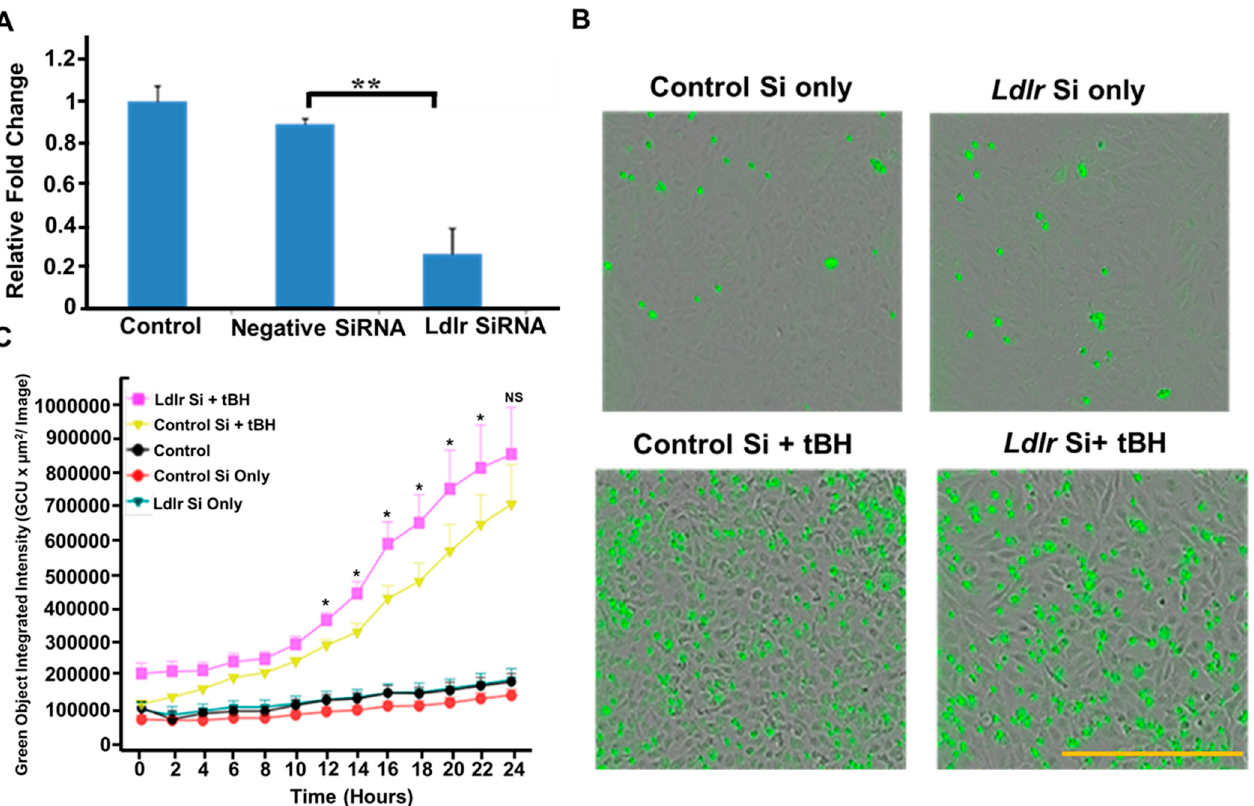
Figure 2. Absence of LDLR exacerbates tBH mediated caspase activation. ( A ) . ARPE-19 cells were transfected with negative control siRNA (10 nM) or LDLR siRNA (10 nM). ( B ). The expression of LDLR mRNA in relation to GAPDH 24 h following transfection is shown (mean ± SEM, n = 3, ** p < 0.01). Representative images of caspase-3/7 positive cells 24 h post treatment. ( C ). Quantification of the activation of caspase-3/7 (green, fluorescent staining) for up to 24 h showing the increased activation of caspase-3/7 in LDLR silenced cells challenged with tBH (300 µM). Asterisks represent comparison of fluorescence intensities of control Si+ tBH and Ldlr Si + tBH at various time points . (mean ± SEM, n = 6). NS: not significant. * p < 0.05, scale bar: 400 µm.